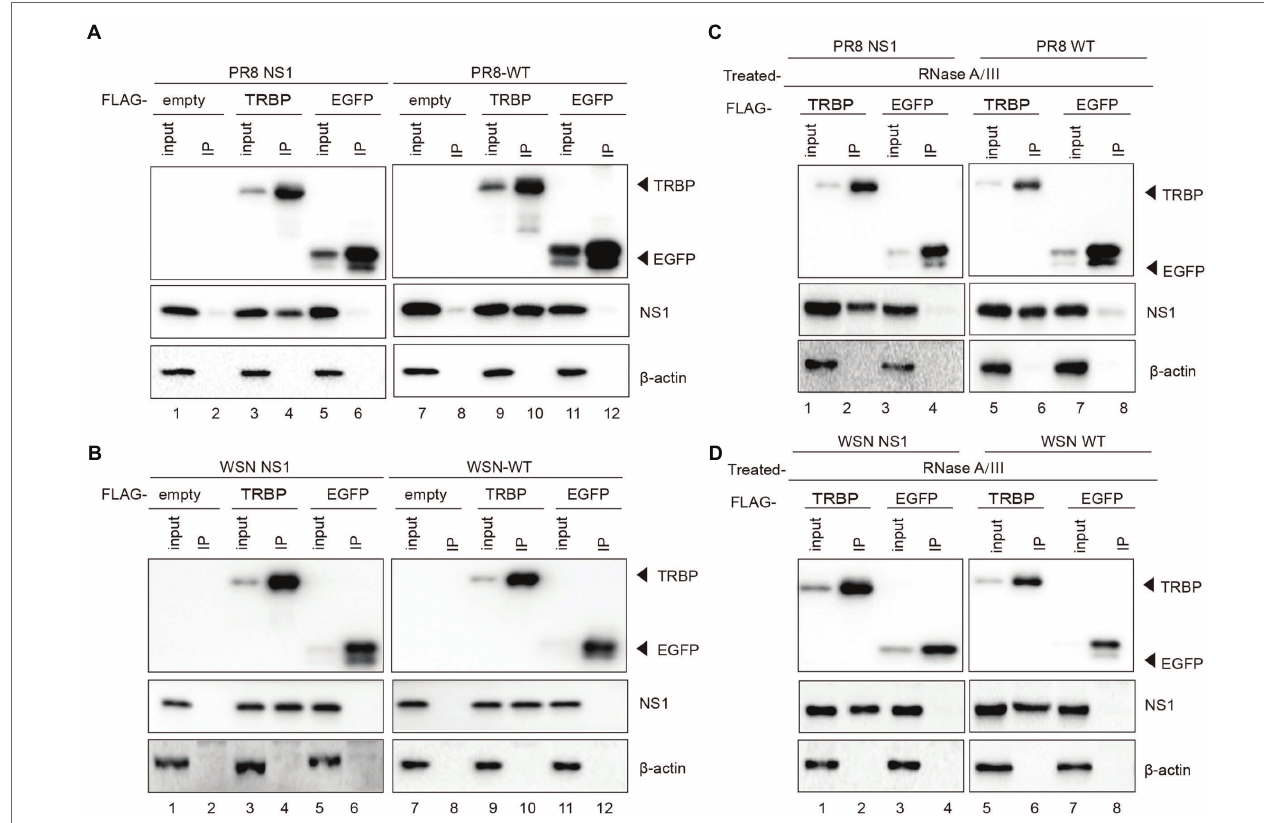
FIGURE 1 | IAV NS1 interacts with TRBP. (A) Plasmids encoding PR8 NS1 and FLAG-TRBP or FLAG-EGFP or empty vector were co-transfected into 293 T cells for 48 h (lanes 1–6). 293 T cells were transfected with FLAG-TRBP or FLAG-EGFP or empty vector for 24 h before infected with PR8-WT (MOI = 1) for 24 h (lanes 7–12). Immunoprecipitations were performed with anti-FLAG antibody. FLAG-tagged proteins, NS1, and β -actin were detected with specific antibodies. (B) Plasmids encoding WSN NS1 and FLAG-TRBP or FLAG-EGFP or empty vector were co-transfected into 293 T cells for 48 h (lanes 1–6). 293 T cells were transfected with FLAG-TRBP or FLAG-EGFP or empty vector for 24 h before infected with WSN-WT (MOI = 1) for 24 h (lanes 7–12). Immunoprecipitations were performed and processed as in (A) . (C,D) The NS1-specific interaction with TRBP persists in the presence of RNase. RNase A (10 mg/ml) and RNase III (5 U/ml) were treated with cell lysates. Immunoprecipitations were performed with anti-FLAG antibody. Samples were analyzed by SDS–PAGE with the indicated